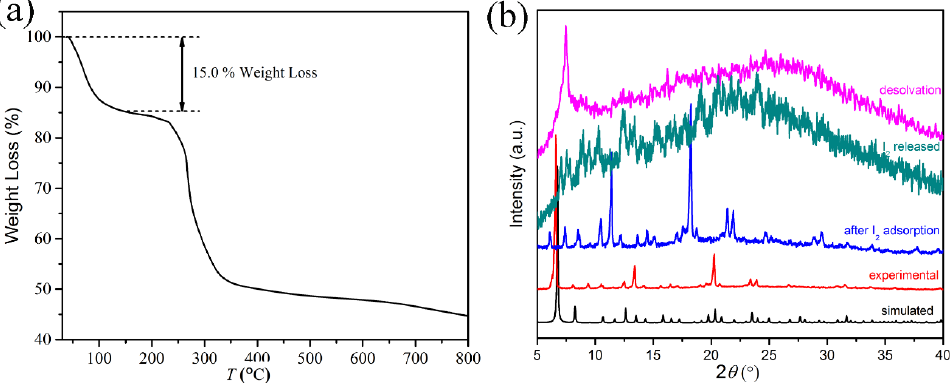
Figure 2 . ( a ) TG analysis of compound 1 . ( b ) PXRD patterns of compound 1 .